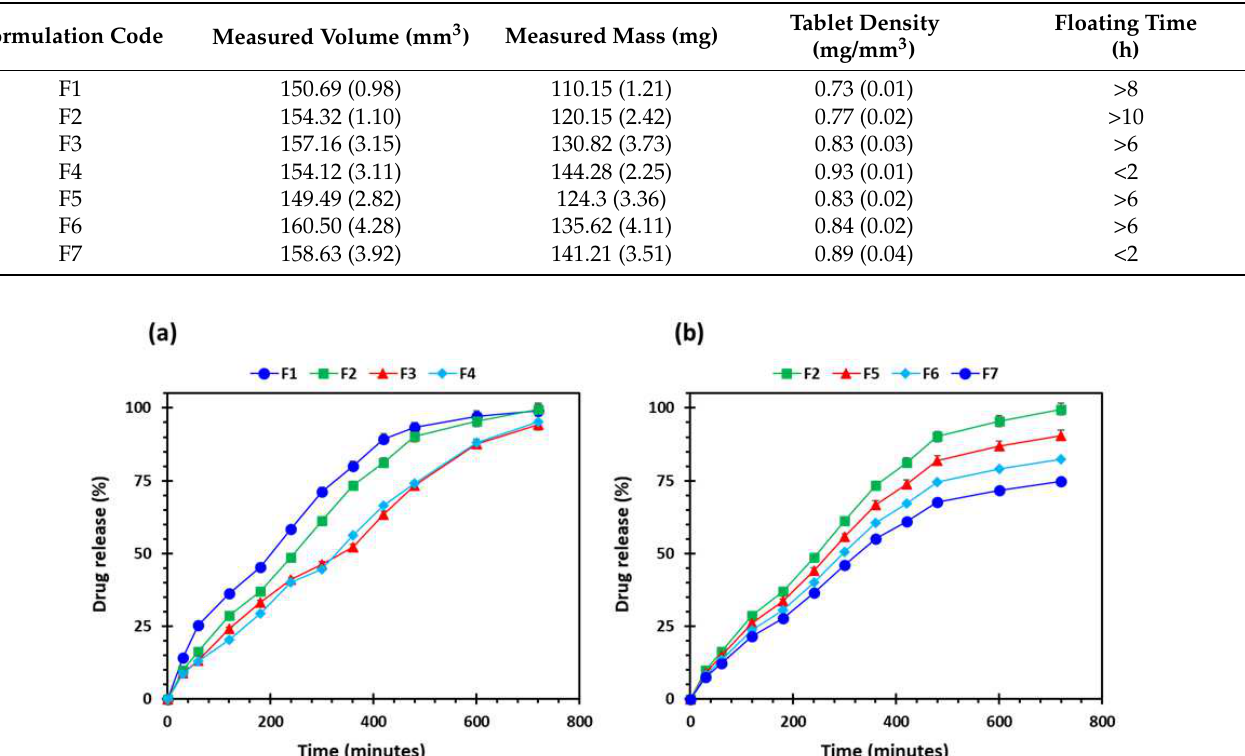
Table 4. Physical parameters and floating time of 3D-printed tablets ( n = 5).